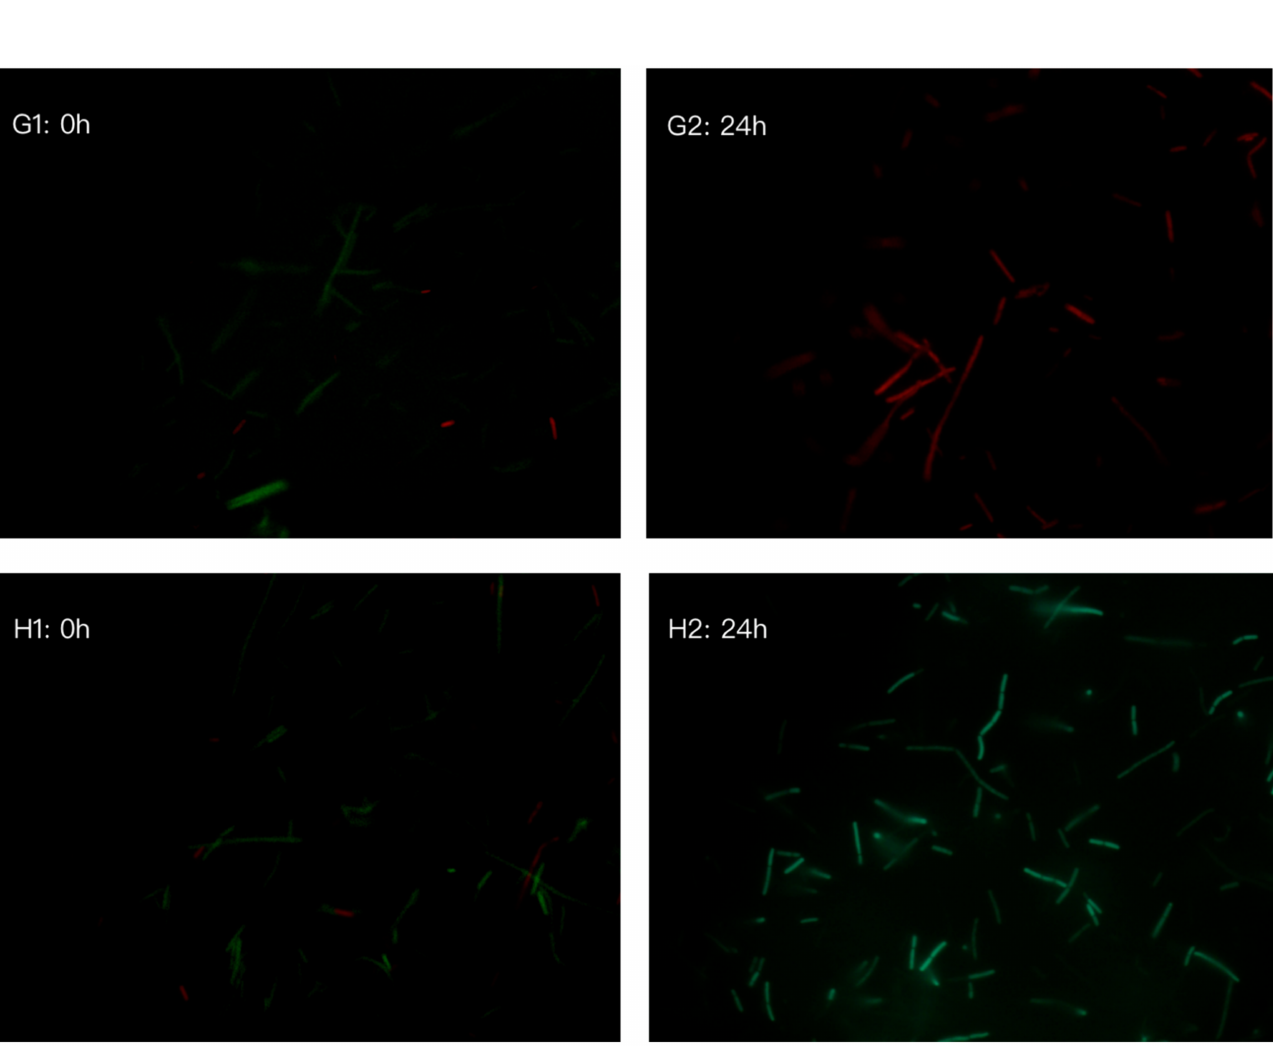
Figure 4. Bacterial viability determined using the LIVE / DEAD BacLight TM Bacterial viability kit. Incubation with lactoferricin (Lfcin) and lactoferrampin (Lfampin) at 0 and 24 h. ( A ) E. coli ATCC 25922 incubated with deer Lfcin 240 µ g/mL. ( B ) E. coli ATCC 25922 incubated with bovine Lfcin 120 µ g/mL. ( C ) E. coli ATCC 25922 incubated with bovine Lfampin 480 µ g/mL. ( D ) E. coli ATCC 25922 incubated with penicillin (10,000 units/mL) and streptomycin (10,000 µ g/mL). ( E ) E. coli ATCC 25922 incubated with nutrient broth. ( F ) L. acidophilus ATCC4356 incubated with deer Lfcin 480 µ g/mL. ( G ) L. acidophilus ATCC4356 incubated with penicillin (10,000 units/mL) and streptomycin (10,000 µ g/mL). ( H ) L. acidophilus ATCC4356 incubated with MRSc broth. Green fluorescence indicates viable bacteria, red fluorescence indicates non-viable bacteria. Microscope magnification ×